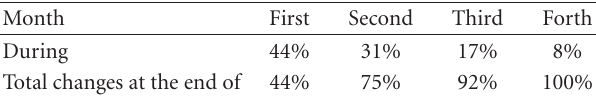
Table 2: Percentage of changes in HbA 1c during time